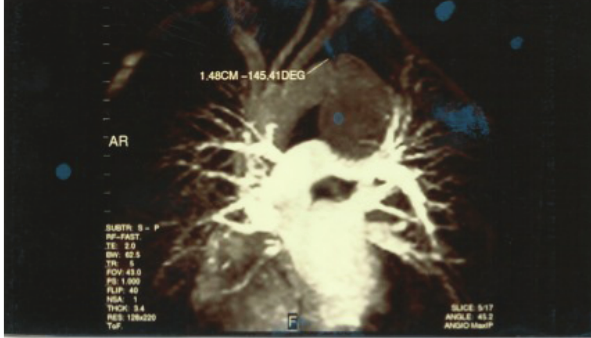
Figure 1: Angio MRI: presence of pseudo-aneurysm of the descen- ding thoracic aorta compressing the bronchus of the left and probably the left recurrent nerve. At the level of the origin of the descending thoracic enjoying a break from the intimate closed chest trauma.